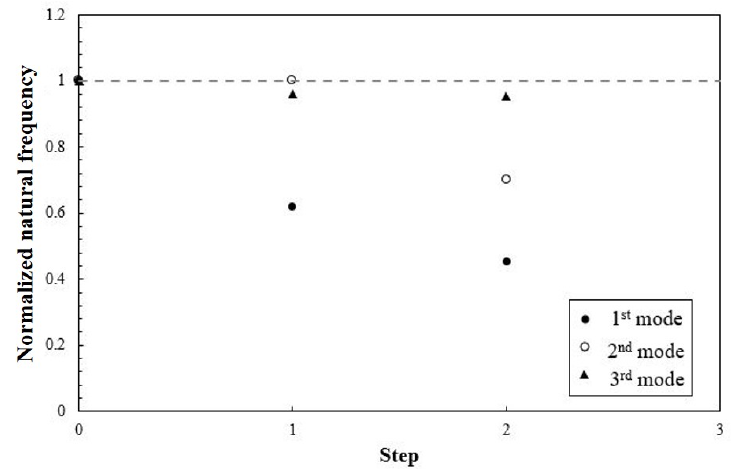
Figure 16. Normalized natural frequency according to the presence of the scour (first, second, and third modes).